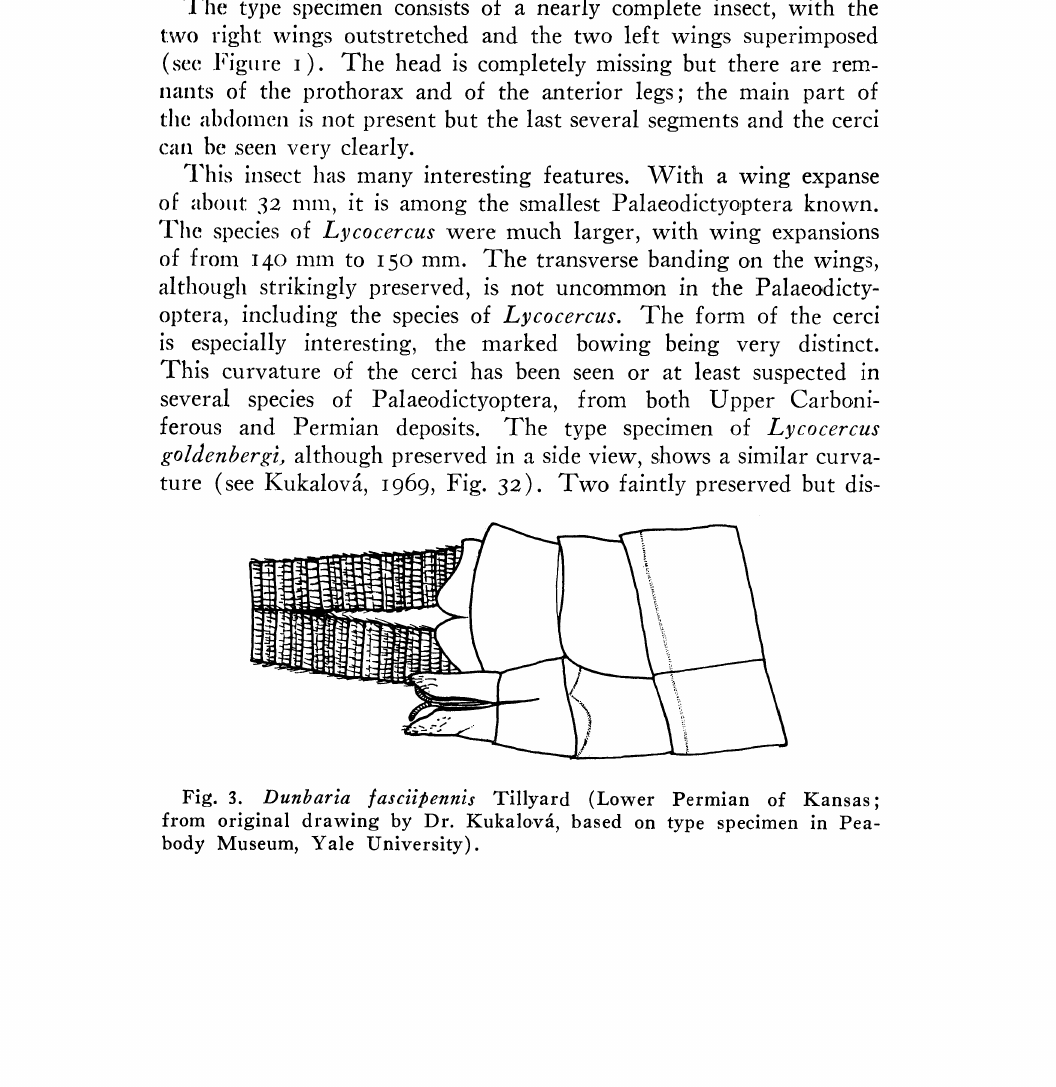
Fig. 3. Dunbaria [asciipennis Tillyard (Lower Permian oi: Kansas; from original drawing by Dr. Kukalo.vi, based on type specimen in Pea- body Museum, Yale